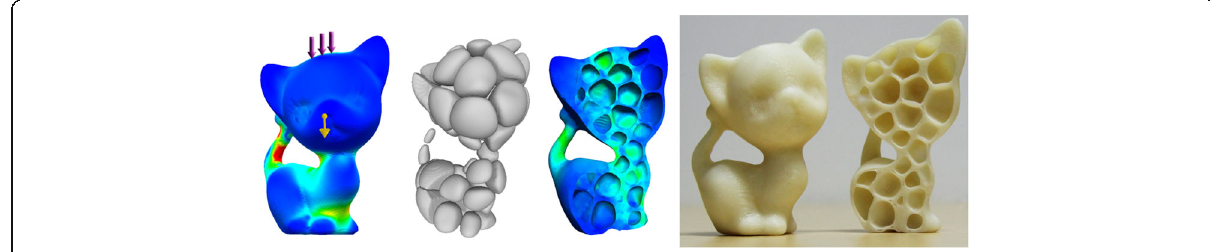
Fig. 2 Honeycomb-like lightweight structure design